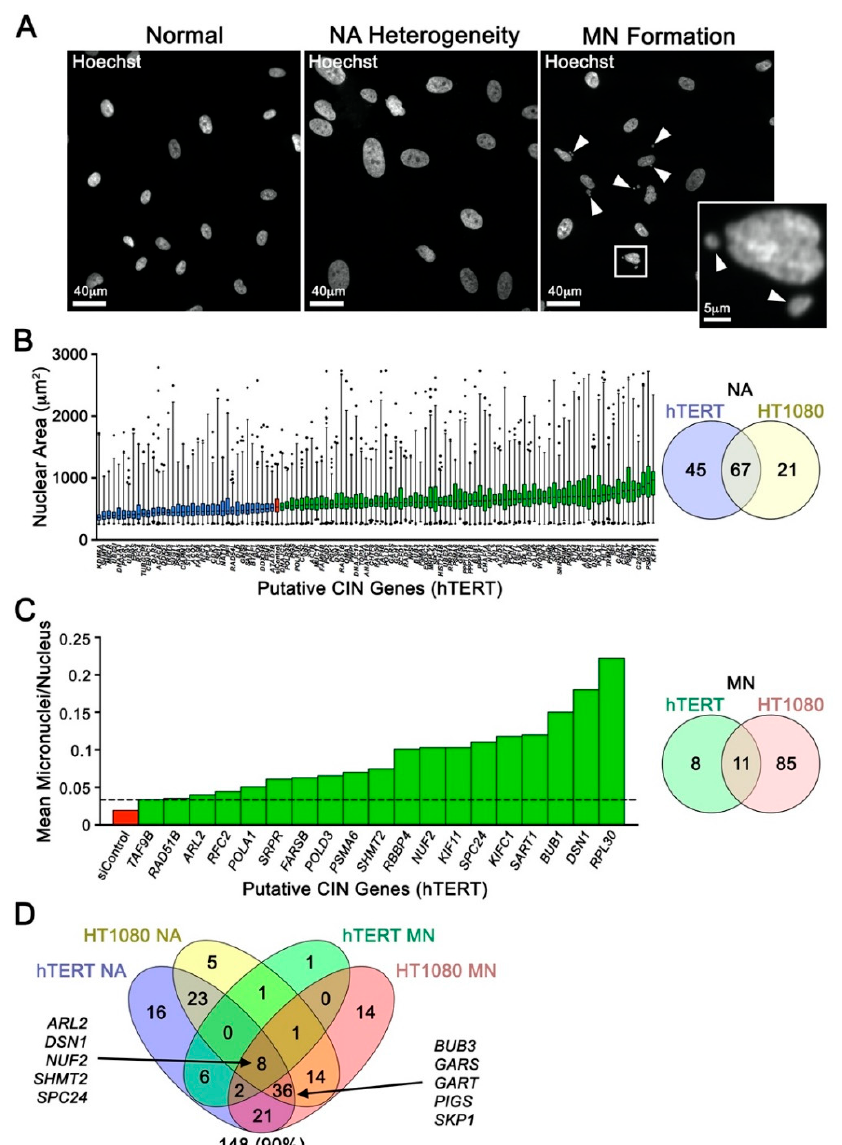
Figure 1. Single-Cell Quantitative Imaging Microscopy Uncovers Putative Chromosome Instability (CIN) Genes. ( A ) Representative fluorescent microscopy images highlighting nuclear area (NA) size heterogeneity (center) and micronucleus formation (right; arrowheads) that accompany silencing of a CIN gene relative to karyotypically stable cells (left). ( B ) Box-and-whisker graph (left) displaying 1 st –99 th percentiles (whiskers) and the interquartile range (25th, 50th, and 75th percentiles) of NA data for putative CIN gene identified from the single-cell quantitative imaging microscopy (scQuantIM) screen performed in hTERT. Note that only genes inducing statistically significant decreases or